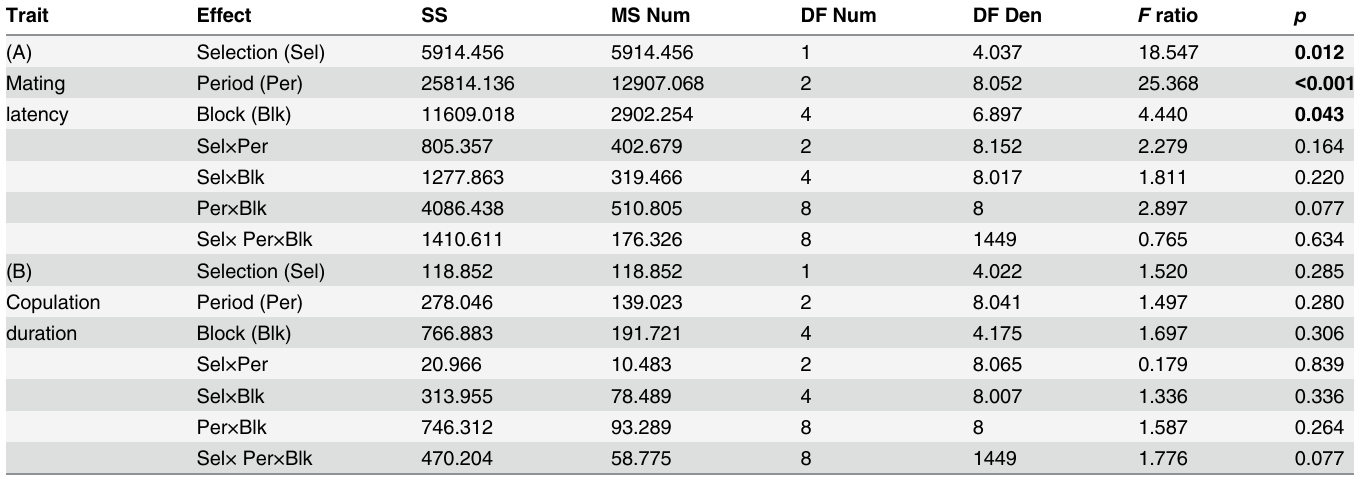
Table 1. Effect of cold shock on pre- and post-copulatory traits. Summary of results of a three-factor mixed model ANOVA considering selection regime (FSB and FCB) and period (recovery period 4, 12 and 30 hours after cold shock) as fixed factors crossed with block as random factor on the (A) mating latency, (B) copulation duration data. p -values in bold are statistically significant. SS: Numerator sum of squares, MS Num: Numerator mean square, DF Num: Numerator degrees of freedom, DF Den: Denominator degrees of